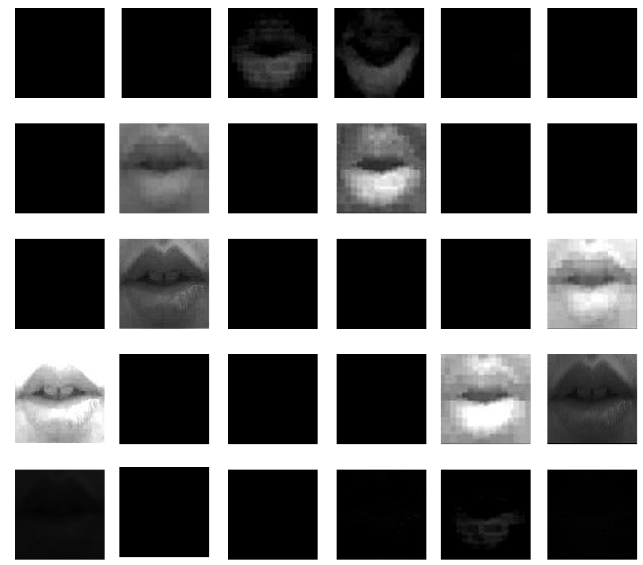
Figure 3. Visualization of partial feature maps generated by resnet network.